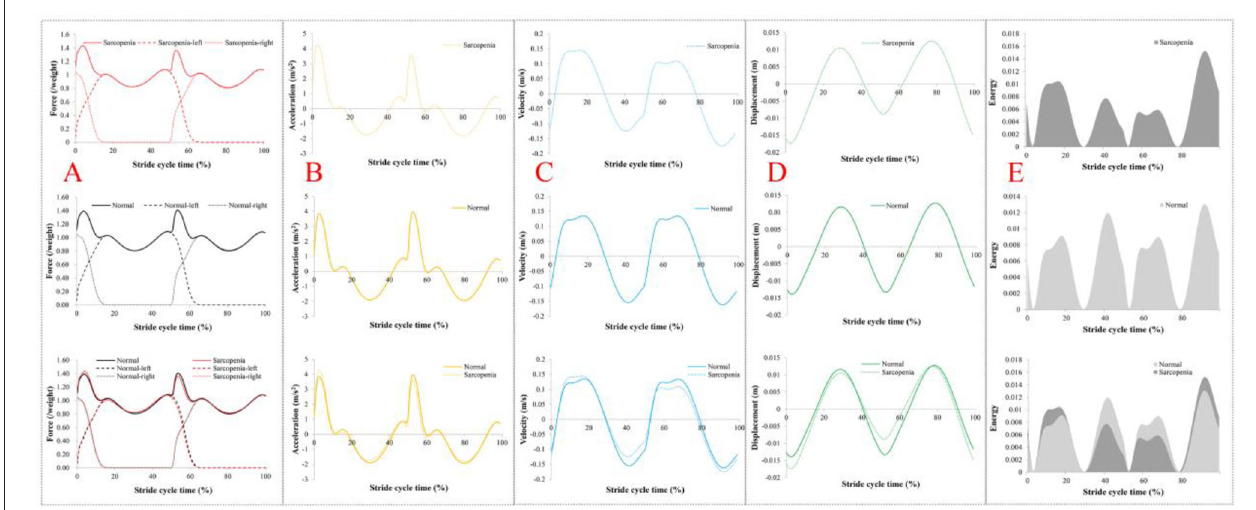
FIGURE 9 | Dynamics results of center of mass (COM). (A) The vertical ground reaction force (VGRF) on COM in a stride cycle. (B) Vertical acceleration of COM in a stride cycle. (C) Vertical velocity of the COM in the stride cycle. (D) Vertical displacement of COM in a stride cycle. (E) The vertical dynamic energy of COM in a stride cycle. In (A) , the dashed line is VGRF on both sides, and the solid line is the resultant force. In (B–D) , dashed lines represent the sarcopenia group and solid lines the normal group. In (E) , the dark color is sarcopenia and the light color is